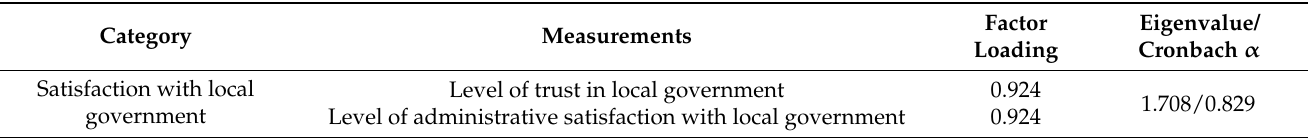
Table 3. Exploratory factor analysis and reliability analysis: Satisfaction with local government.